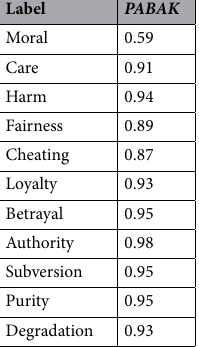
Table 3. Inter-rater agreement for 6983 facebook posts (Study